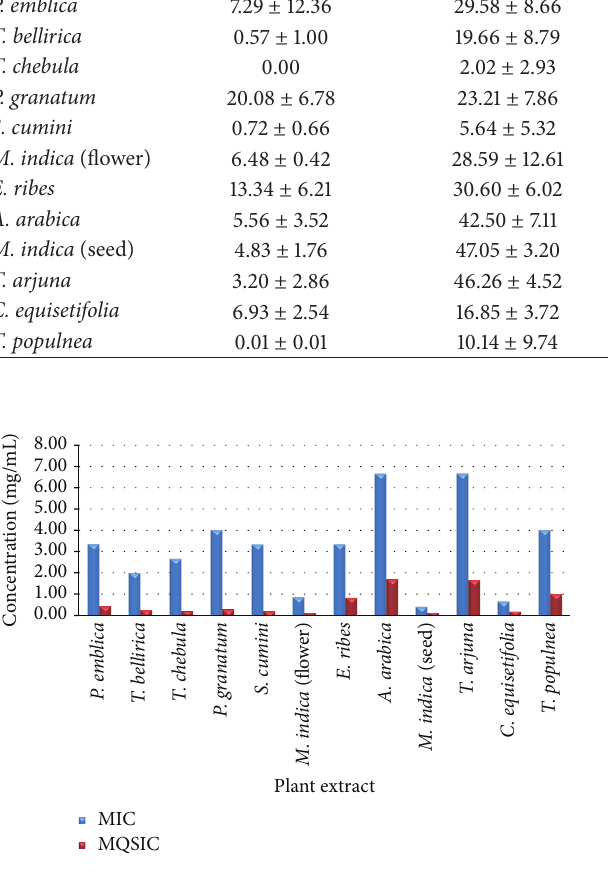
Figure 1: Comparison of MIC values with MQSIC values for anti- quorum sensing activity of plant extracts, detected using biosensor strain C. violaceum 12472.